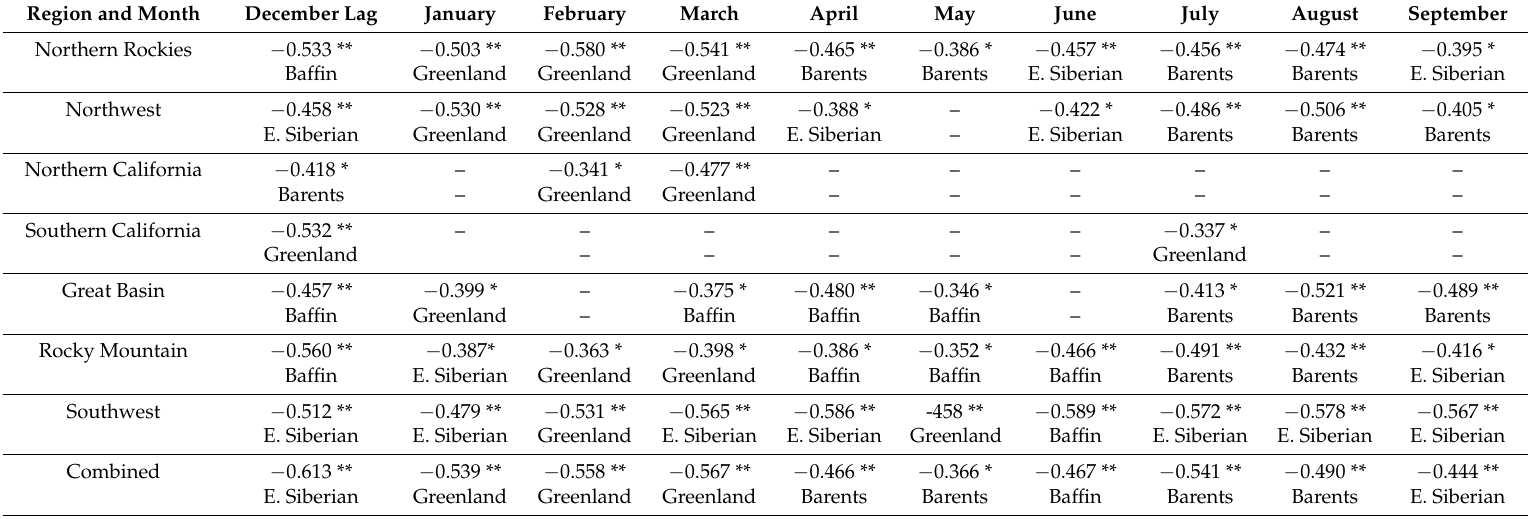
Table 3. Spearman rank-order correlations ( p -values) between monthly regional Arctic sea-ice extent and annual wildfire area burned during 1980–2015. Significance for 2-tailed tests with * p <0.05 and ** p < 0.01. Regions without statistically significant relationships (i.e., p > 0.05 are not shown). Shaded boxes highlight where the regional Arctic sea-ice extent (ASIE) relationship was stronger than that obtained using total ASIE. Dashes (–) indicate no significant